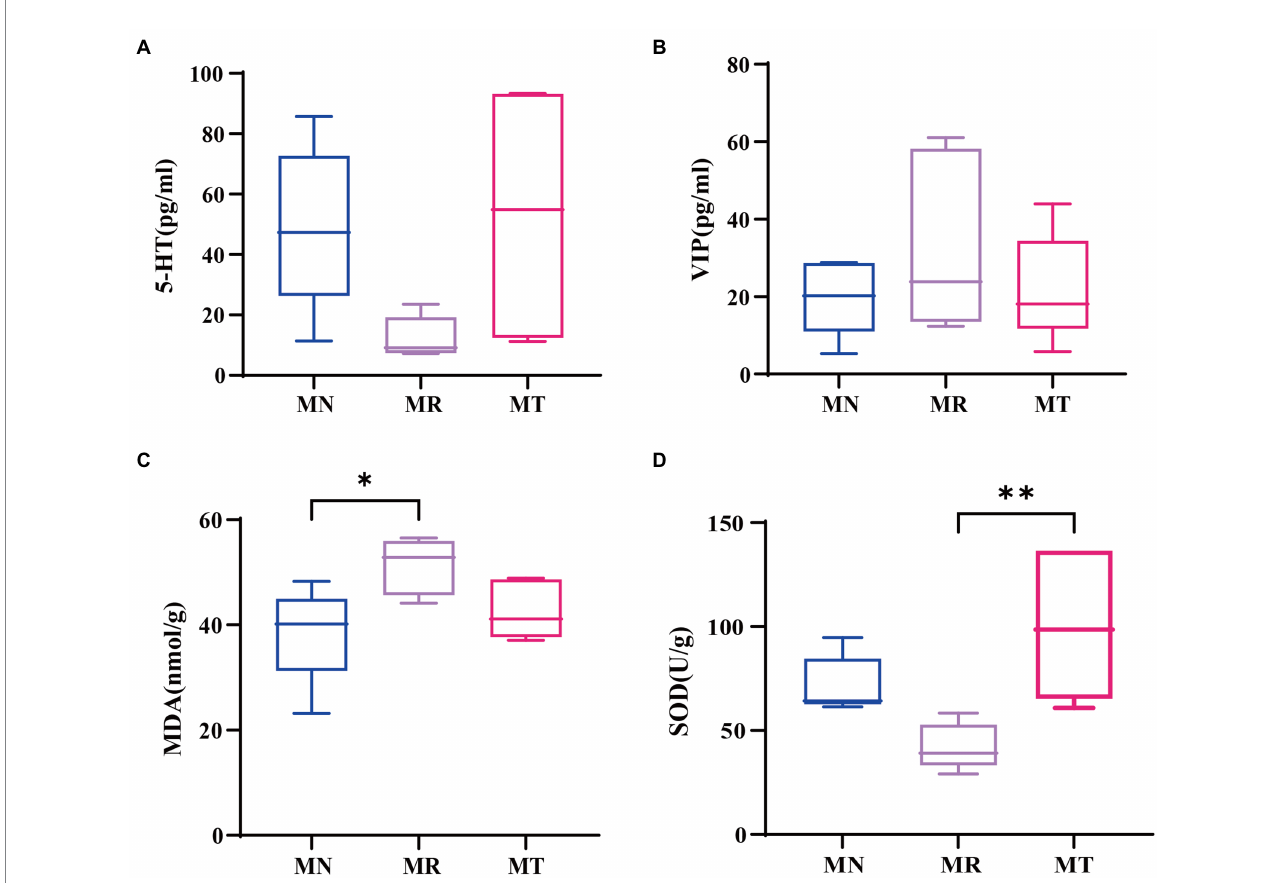
FIGURE 4 Effect of SMD on gastrointestinal hormones and oxidative stress indexes in mice with spleen deficiency constipation. (A) 5-HT content. (B) VIP content. (C) MDA content. (D) SOD content.